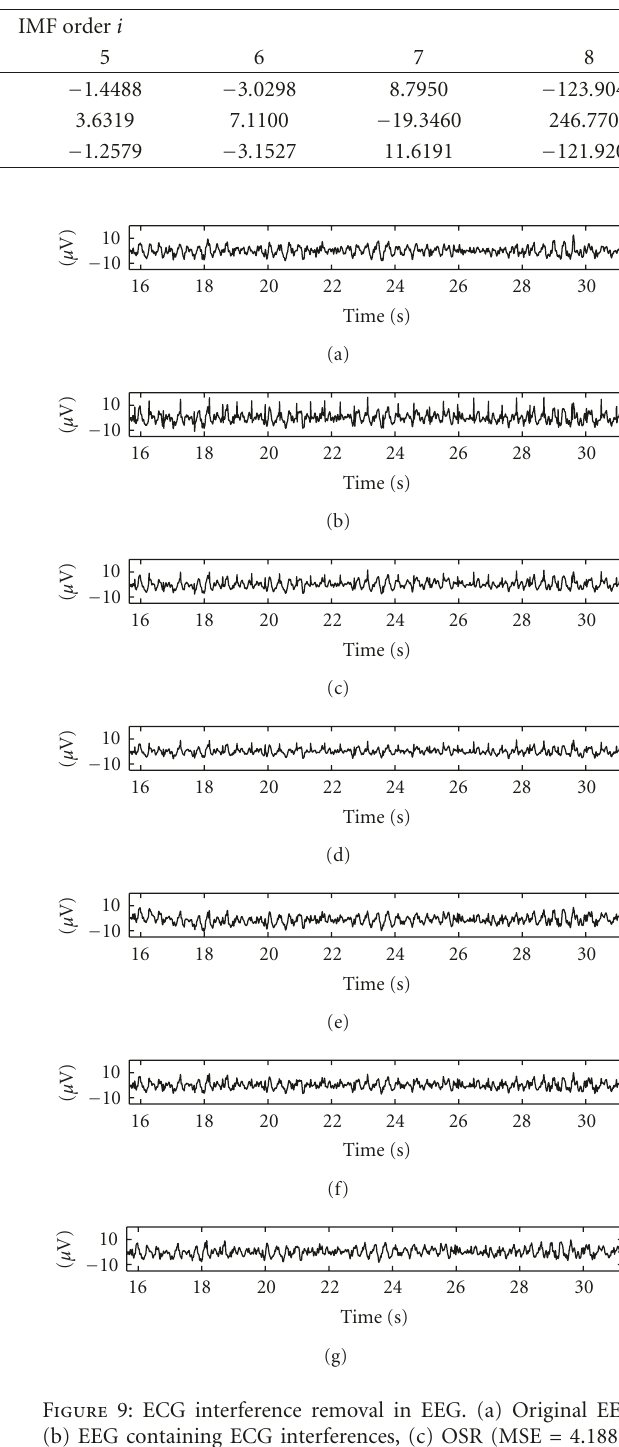
Table 2: Optimal coe ffi cients of the BOSR algorithm ( M = 1).